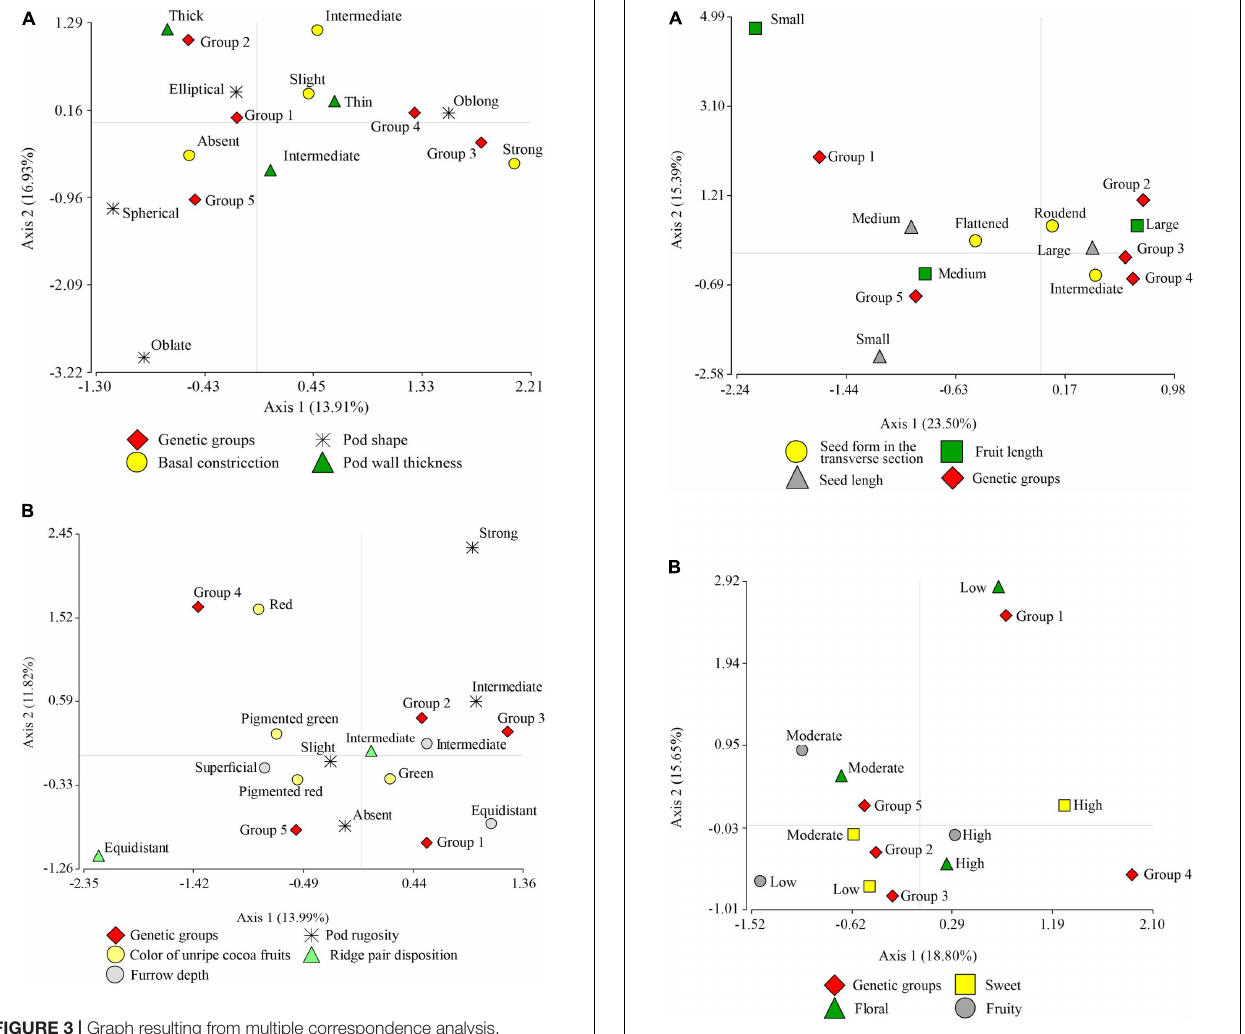
FIGURE 4 | Correspondence analysis graph. (A) Between the descriptor of morphological seed characteristics: seed form in the transversal section, seed length, pod length, and the association with the genetic groups. (B) Between the descriptor of sensory characteristics: sweetness, floral, fruity, and the association with the genetic